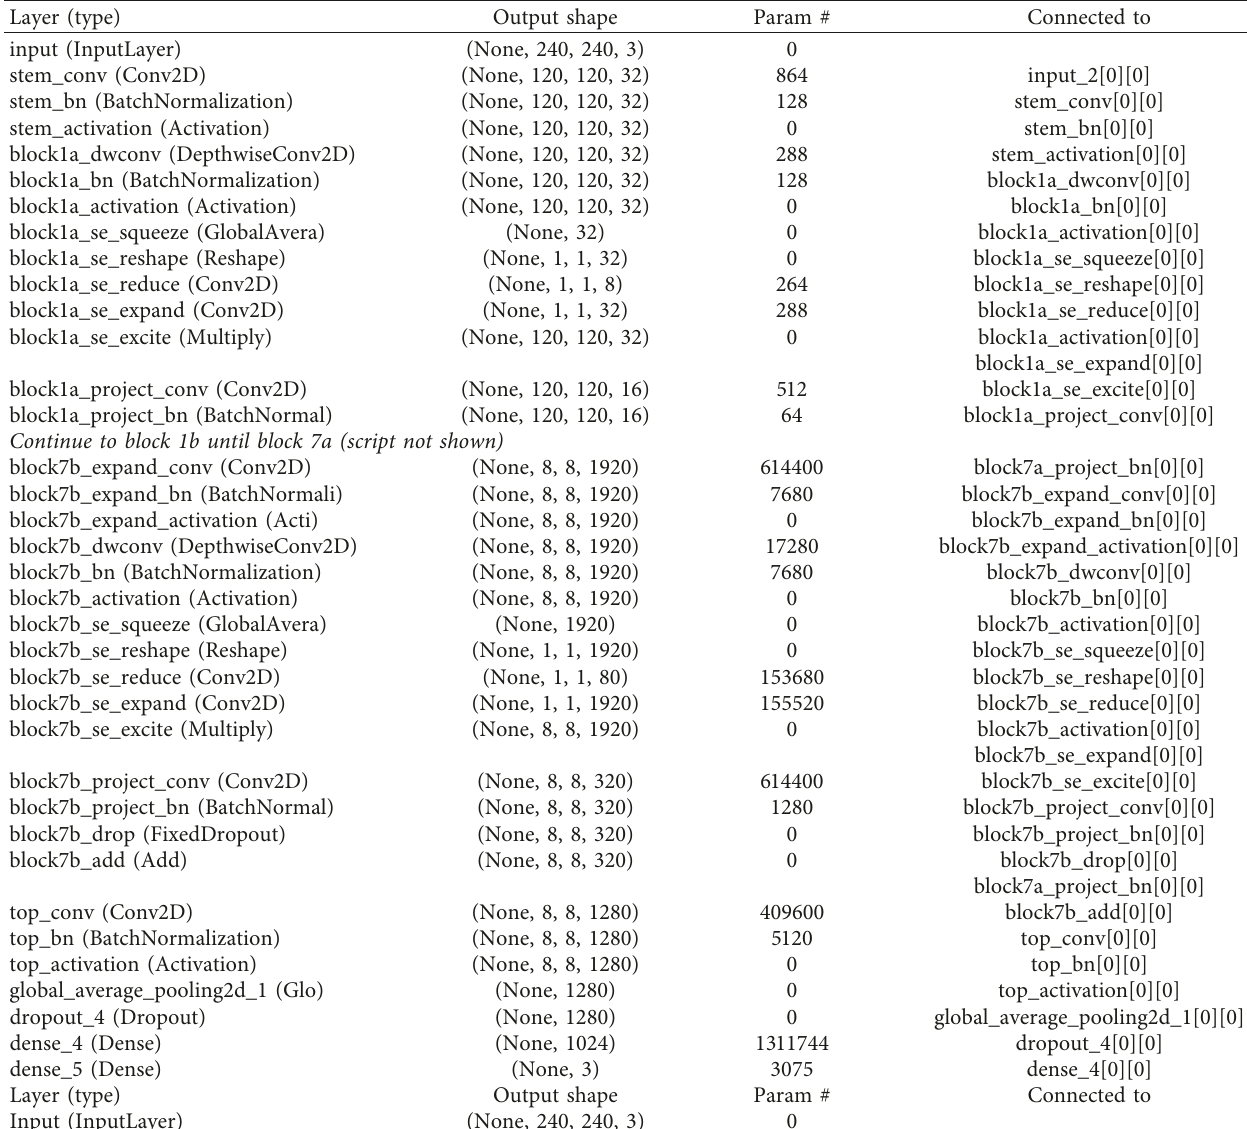
Table 4: Model summary of EfficientNet B1.